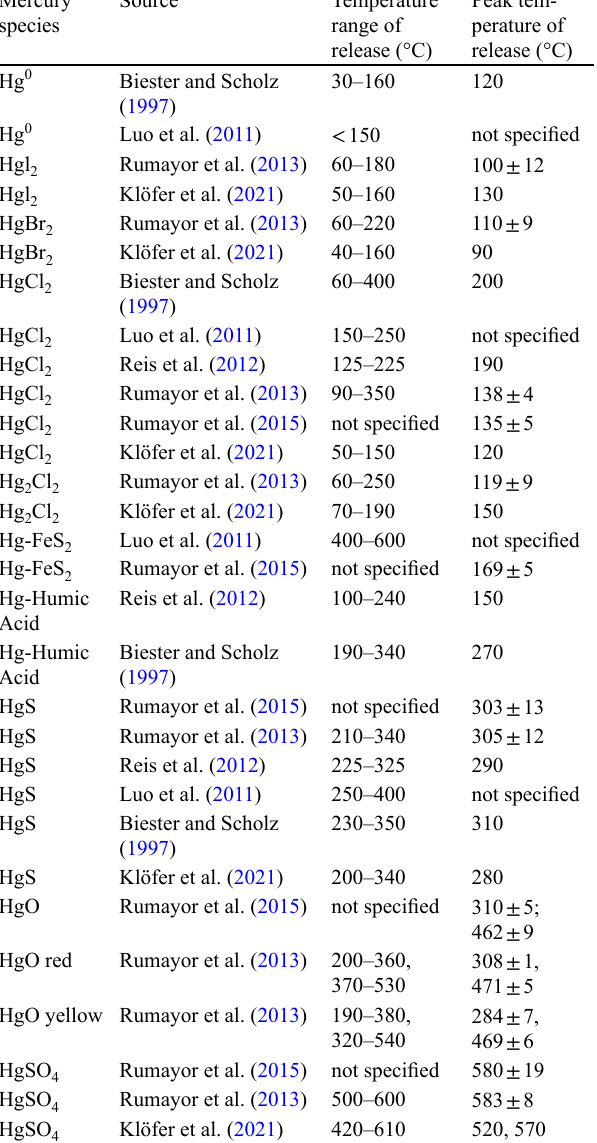
Table 1 Comparison of literature data on mercury release from